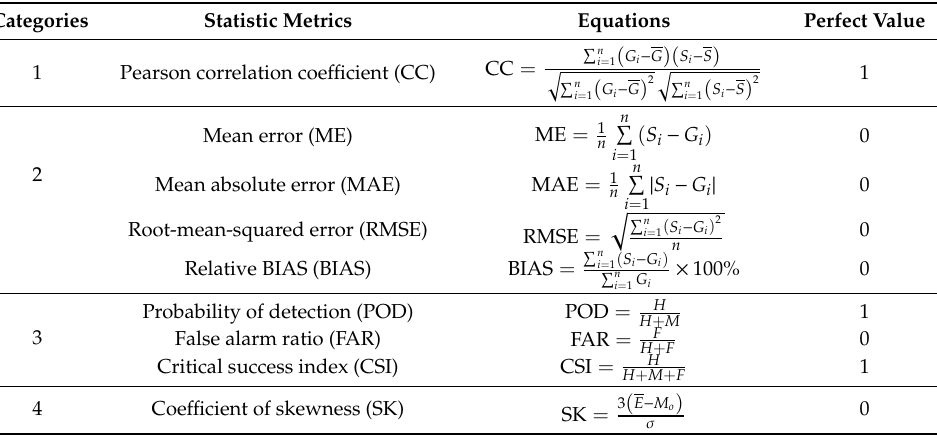
Table 2. List of the statistical metrics used in this